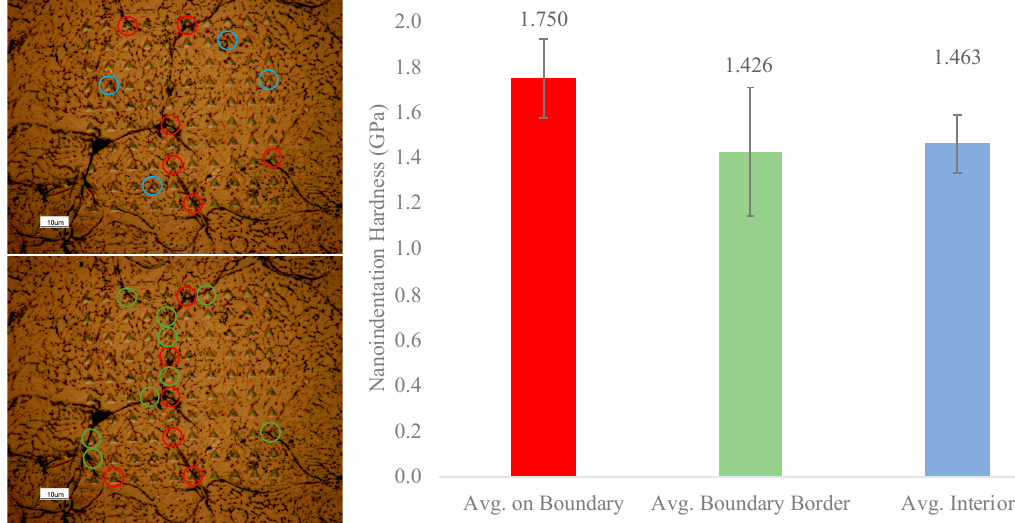
Figure 44. Microstructurally informed nanoindentation specific hardness in cold sprayed Al 6061.